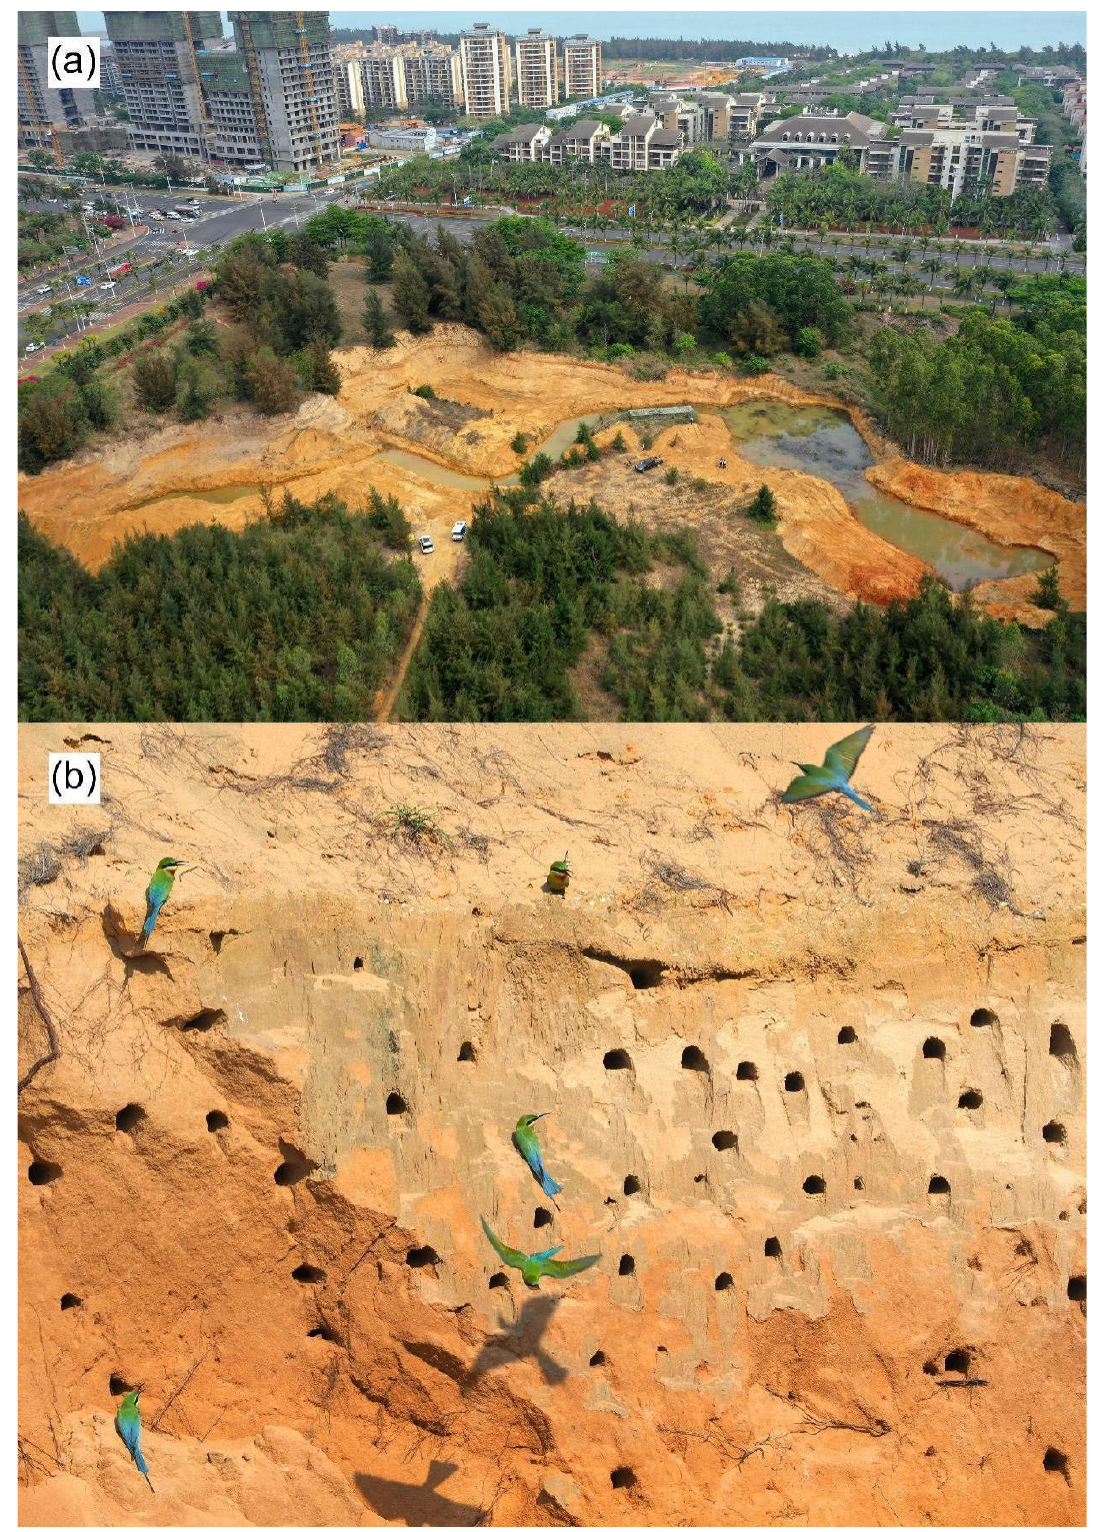
Figure 4. Wuyuanhe Bee-eater Reserve, where manipulated sand digging was conducted in the years 2017 to 2022, 1 month before the blue-tailed bee-eaters ( Merops philippinus ) initiated reproduction. ( a ) Aerial view of the reserve area. ( b ) A sand wall with blue-tailed bee-eaters and their nesting cavities.